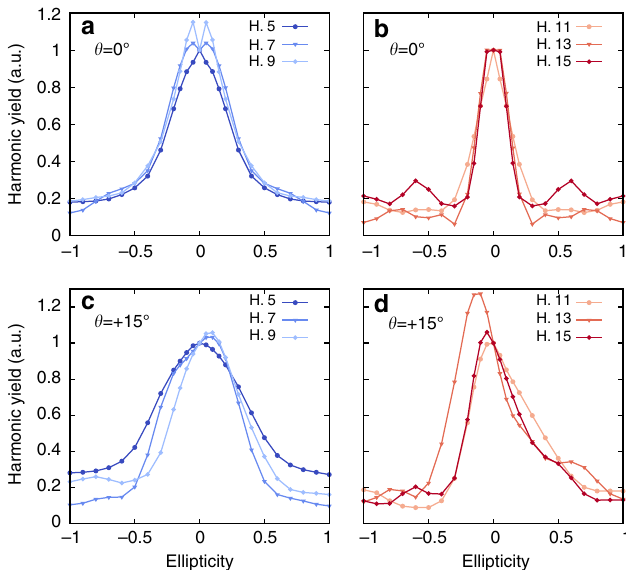
Fig. 1 Ellipticity pro fi les of HHG from bulk silicon. Computed ellipticity dependence of the various odd harmonics (5 – 15) generated from bulk silicon for laser polarization a , b along the Γ X direction ( θ = 0°), and c , d for laser polarization rotated by +15° around the [001] crystallographic